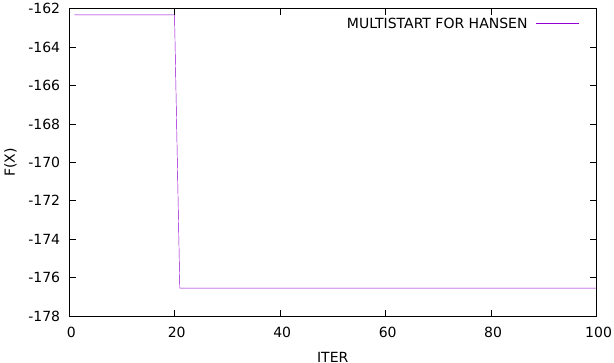
Figure 1. Progress of Multistart for the Hansen function.